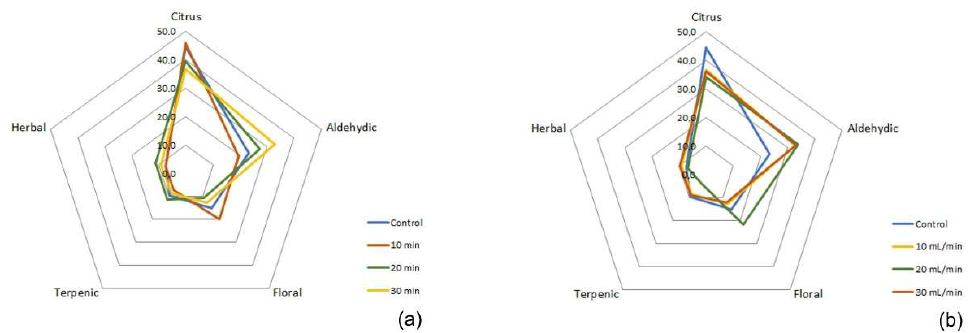
Figure 4. Aroma profile radar for the pasteurized orange juice and plasma-treated orange juice: ( a ) treated at 10 mL/min; ( b ) treated for 30 min.